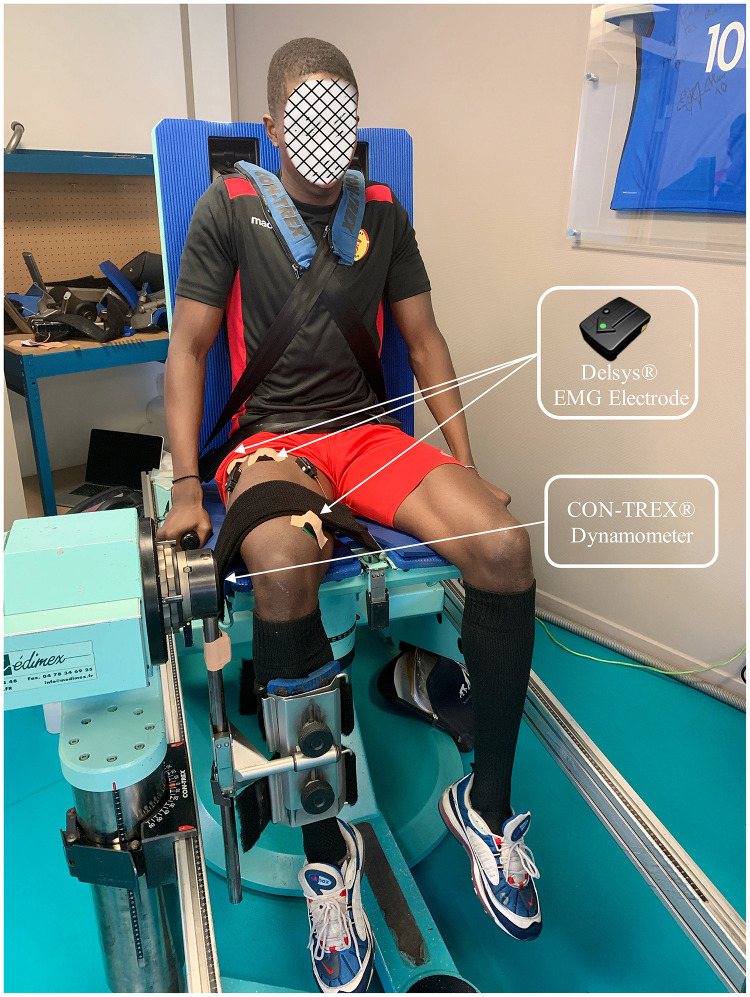
An example of participant experimenting.